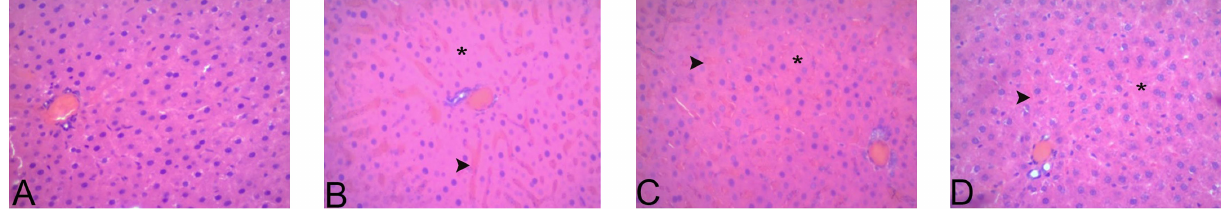
Figure 1. Representative micrographs showing the liver samples of all experimental groups. Control group (A) shows normal liver architecture. Ischemia-reperfusion (I/R) group (B) shows severe necrotic hepatocytes (*) and congestion (arrowhead) compared to the control group. Section from a rat of group III: I/R + uridine (before reperfusion) (C) shows moderately necrotic hepatocytes (*) and congestion (arrowhead) compared to group II. Group IV: I/R + uridine (5 minutes before I/R) (D) showing mild necrotic hepatocytes (*) and congestion (arrowhead) compared to group II. × 20- hematoxylin–eosin